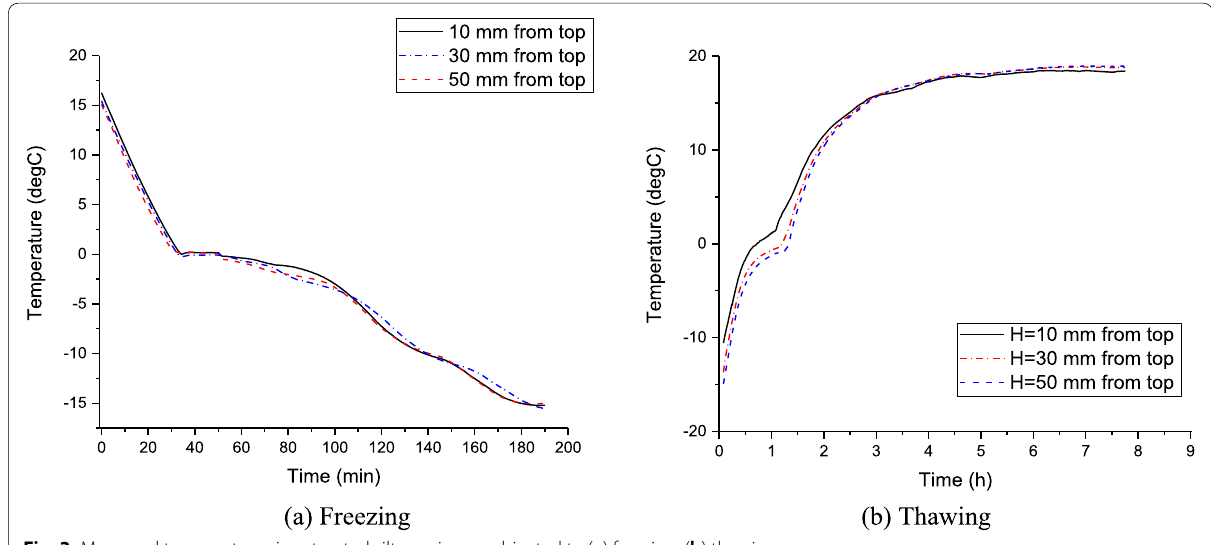
Fig. 3 Measured temperatures in saturated silt specimen subjected to ( a ) freezing, ( b )